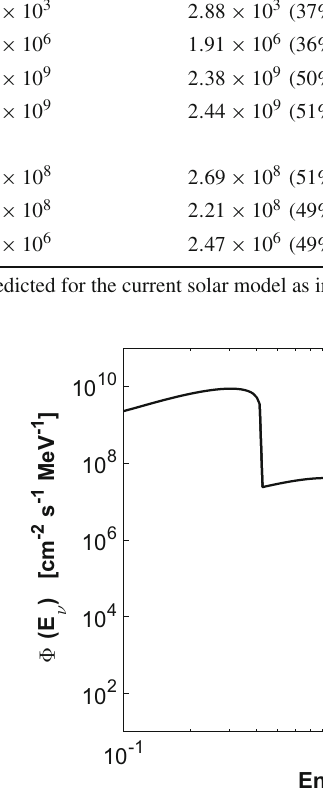
solar nuclear reactions (considered in this study) are very dif- ferent from the neutrino spectra emitted by the solar nuclear reactions (without neutrino oscillations). In particular, it is possible that the next generation of solar neutrino detectors will be able to measure Φ k , e (cid:10) ( E ) . The sterile neutrino spec- trum of all nuclear reactions have very small amplitudes and have identical spectral shapes although occurring at differ- ent neutrino energy ranges. In Table 1 we show the predicted neutrino fluxes for the leading solar nuclear reactions for the current solar standard model as well as the predicted ratios of sterile neutrino fluxes and electronic neutrino fluxes. The small values of sterile neutrinos are due to the very small mixing angle θ 14 . Only 4% of neutrinos arriving on Earth have a sterile flavour. This value is almost constant across all solar nuclear reactions. Nevertheless there is a small increase for the sterile neutrinos from the pp reaction and a small decrease for sterile neutrinos from the 8 B reaction. This is a consequence of the fact that the pp and 8 B nuclear